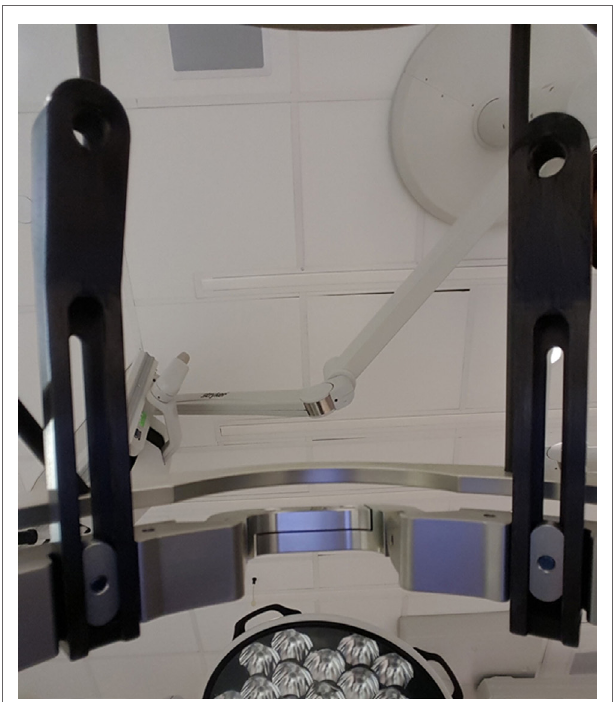
FIGURe 4 | simulated patient perspective of presurgical positioning, situated from within the CRW frame, prior to draping .